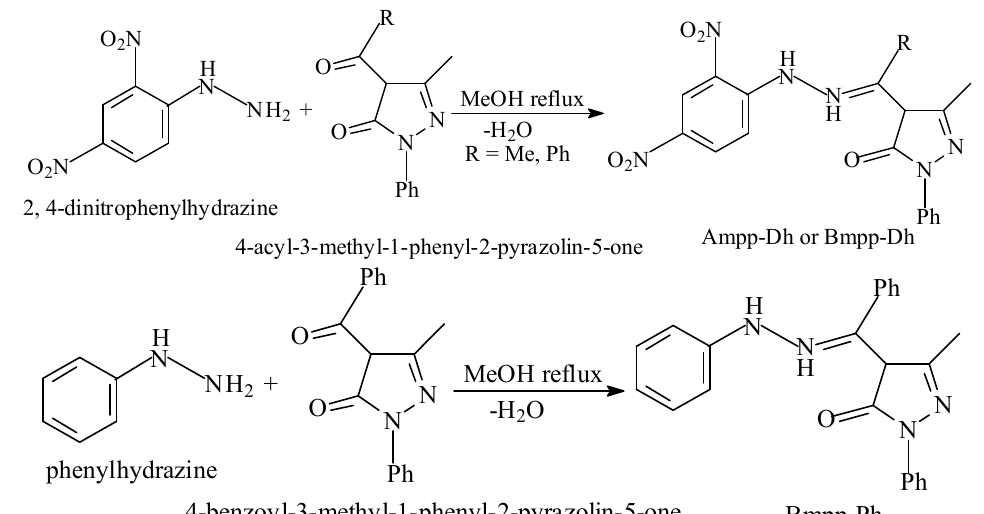
Figure 2. Synthesis scheme of phenylhydrazones.